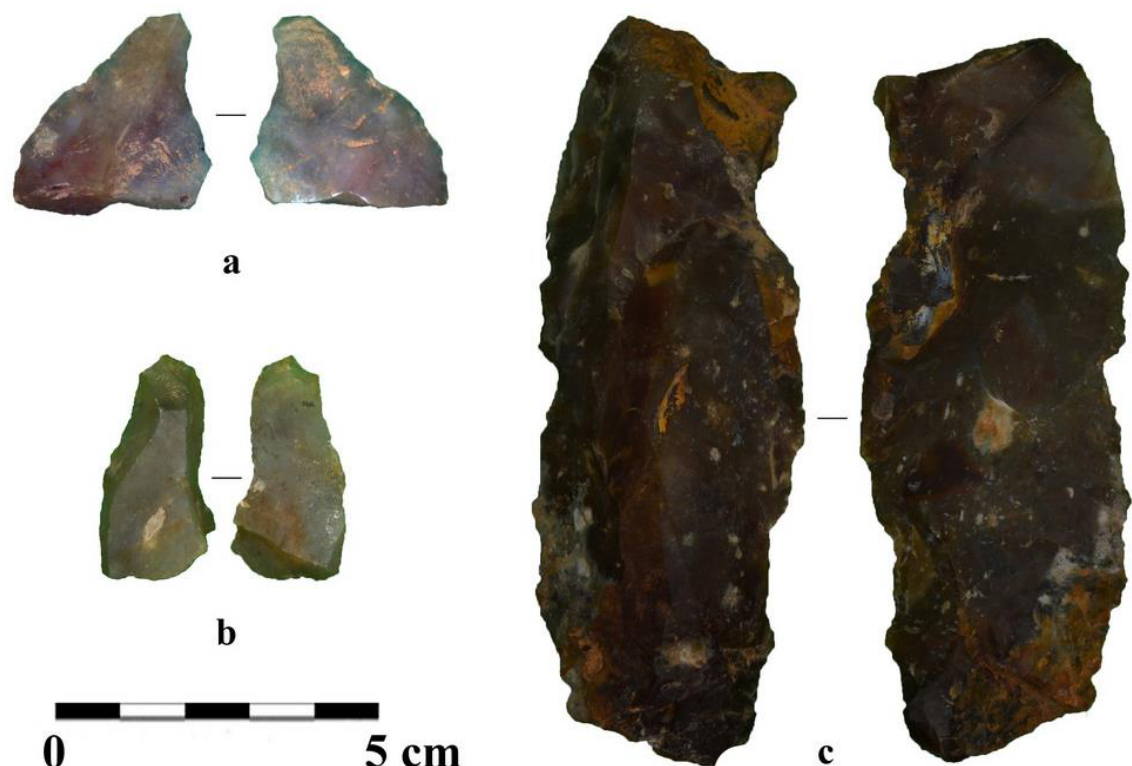
Figure 11. Lojanik 2, samples of raw material: a, b (trench C, square VIII, split 1) flakes; c (trench B, square XIII, split 3)